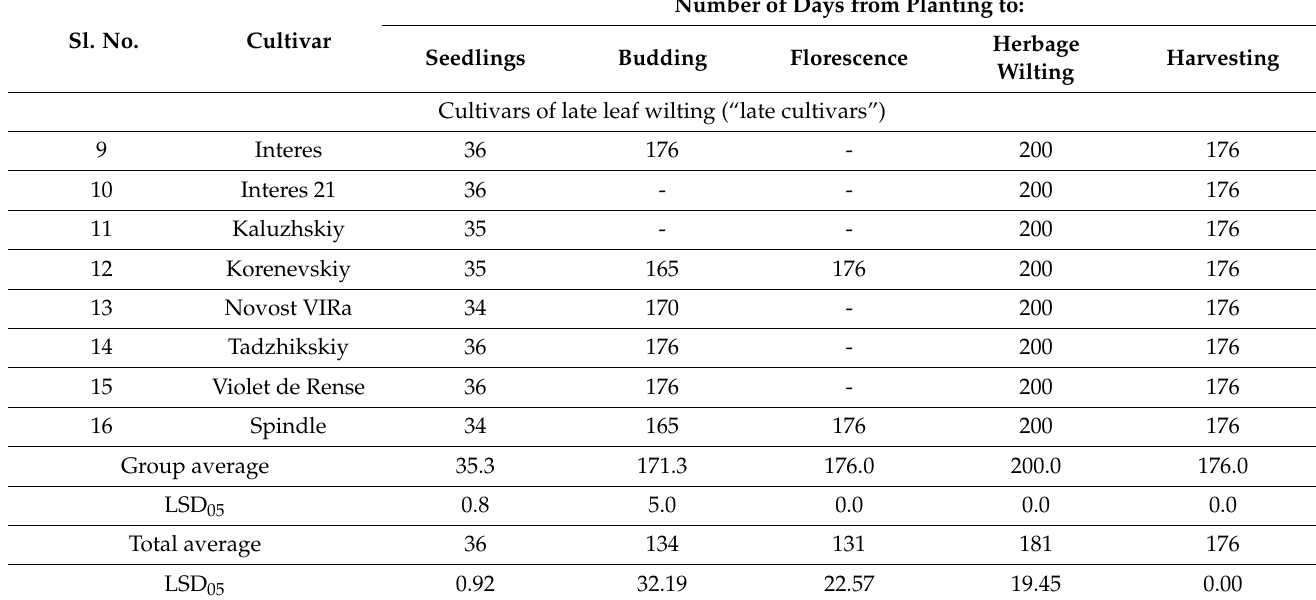
The data obtained from the examination of the powdery mildew infestation of leaves (Figure 5) are presented in Figure 6.